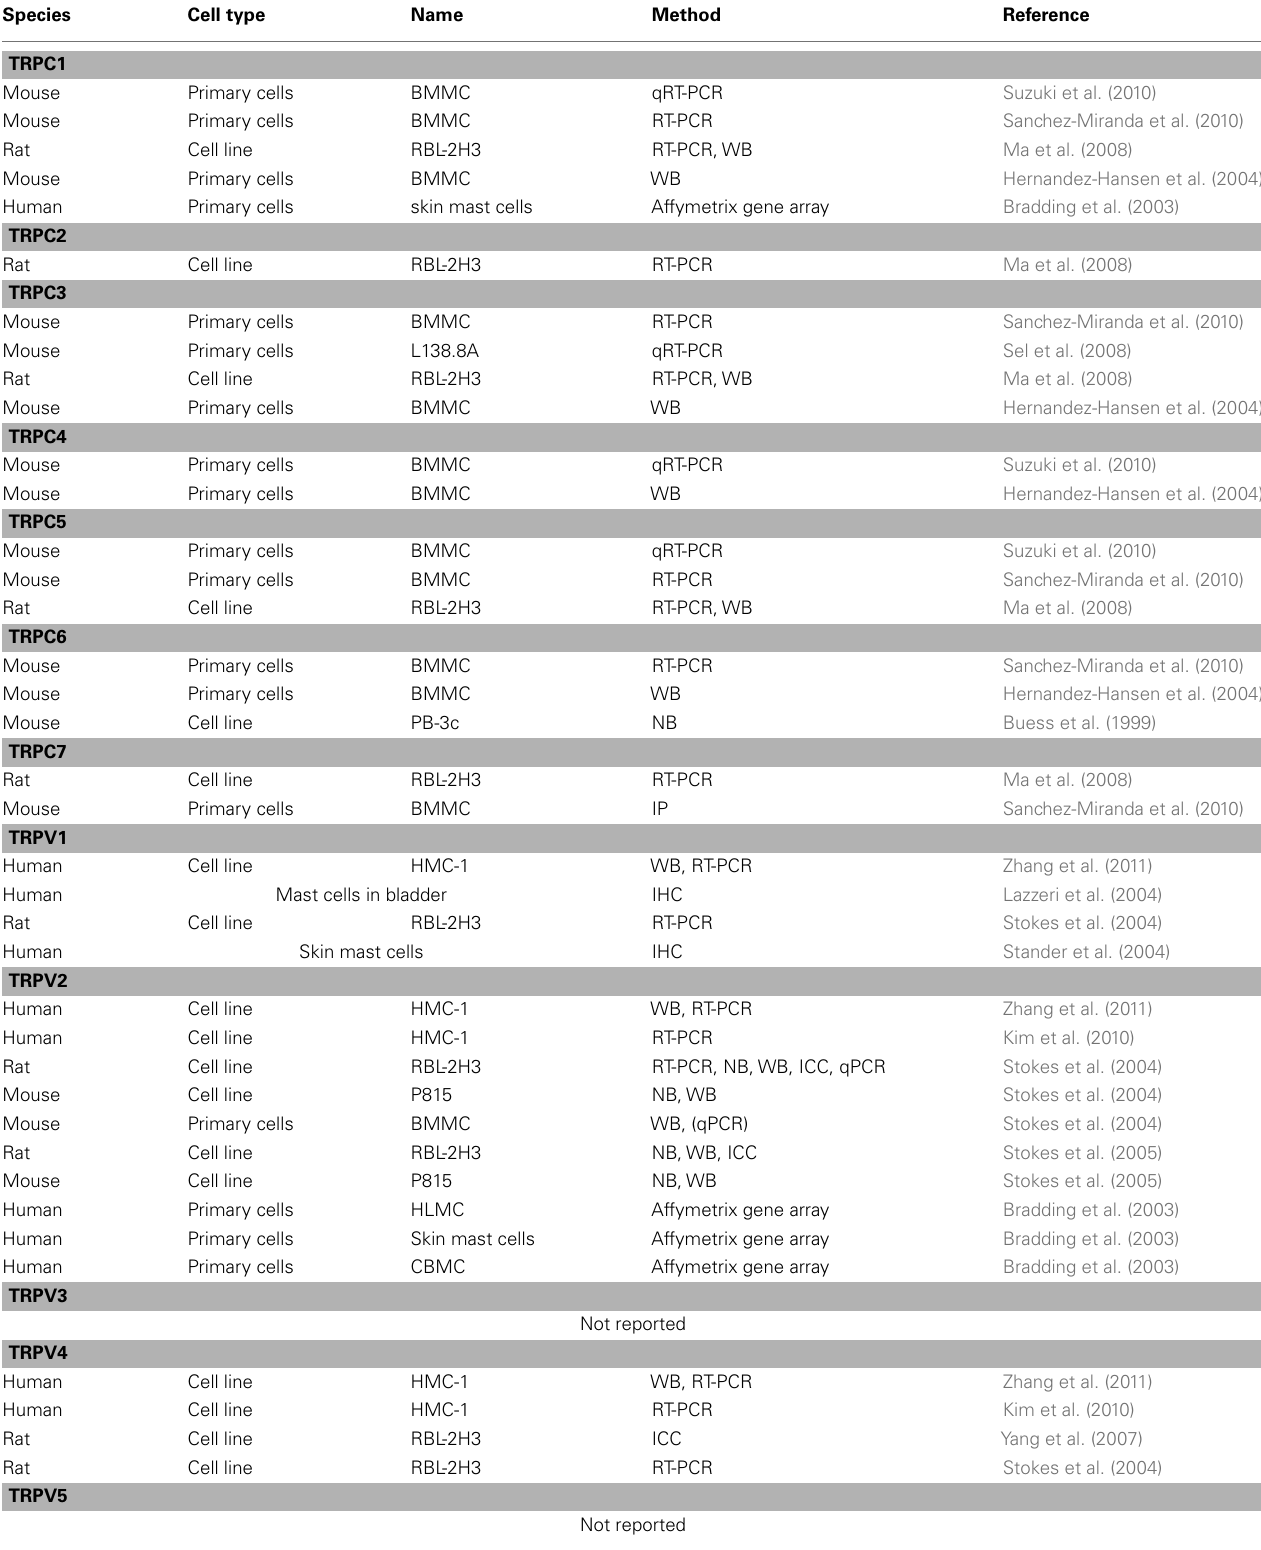
Table 2 | Expression ofTRP transcripts and proteins in mast cell